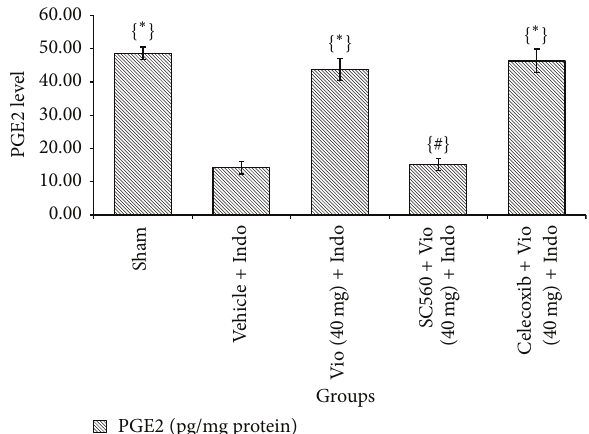
Figure 5: Effect of violacein (40 mg/kg, orally) on mucosal PGE 2 level in indomethacin-induced ulcer. Values are mean ± SD ( 𝑛 = 6 ). ∗ 𝑃 < 0.05 compare vehicle + Indo with all the groups; # 𝑃 < 0.05 compare Vio (40mg) + Indo with SC560 (or) Celecoxib + Vio (40 mg) + Indo. Indo: indomethacin; Vio: